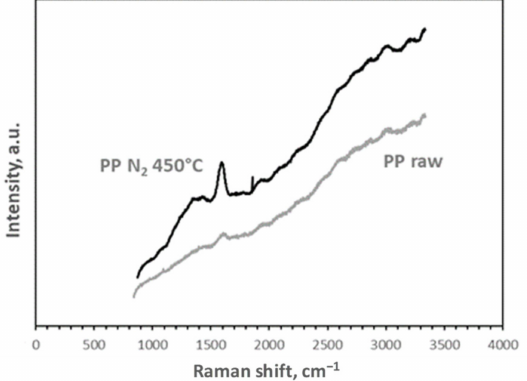
Figure 10. Raman spectra of a petroleum pitch (PP raw) and of the same petroleum pitch after annealing at 450 ◦ C (PP N 2 450 ◦ C) in